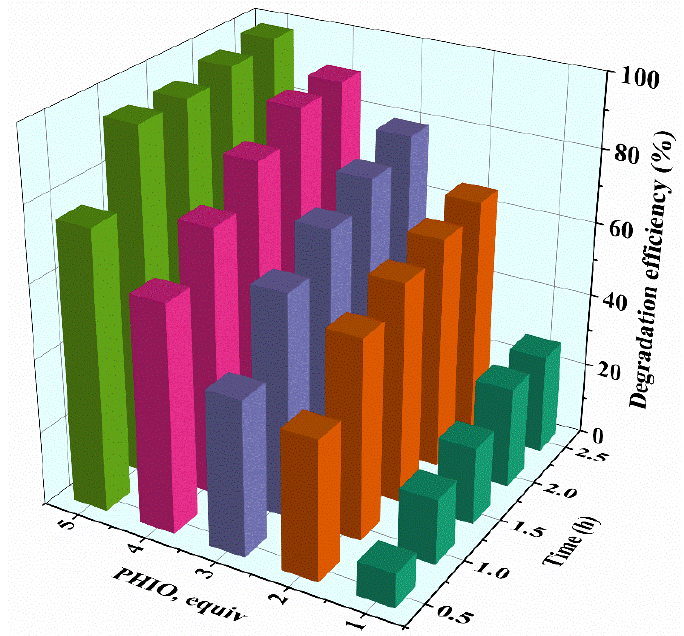
Figure 6. Degradation efficiency for the [Fe III (TCPP)]-catalyzed degradation of gentian violet by various concentrations of PhIO under various reaction times. Conditions: gentian violet 0.05 mM; [Fe III (TCPP)] 0.005 mM; solvent MeOH and 303 K.